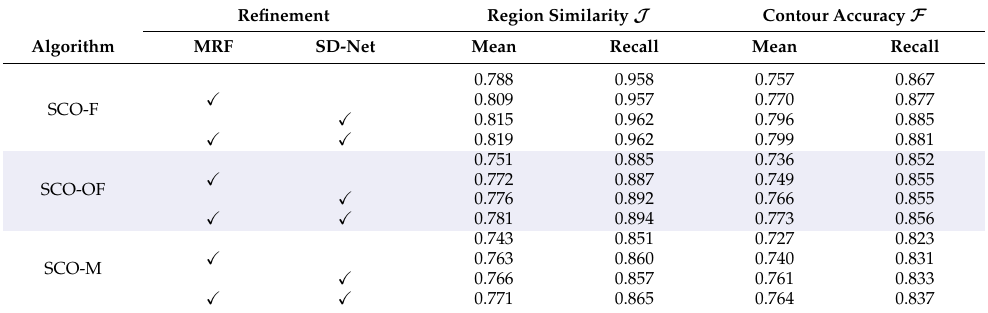
Table 1. Ablation studies on the validation set in DAVIS2016 according to the refinement methods.